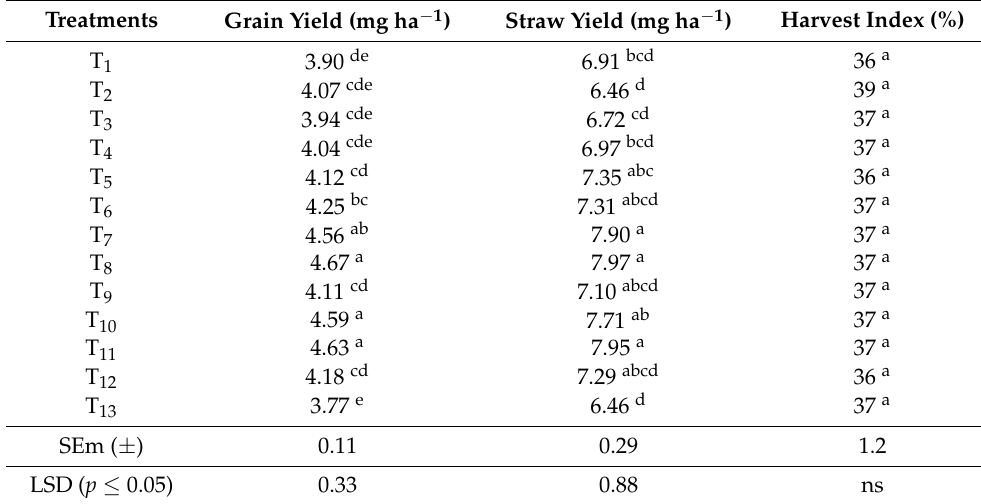
Table 5. Effect of different doses and frequencies of zinc application on wheat yield (mg ha −1 ). Treatments